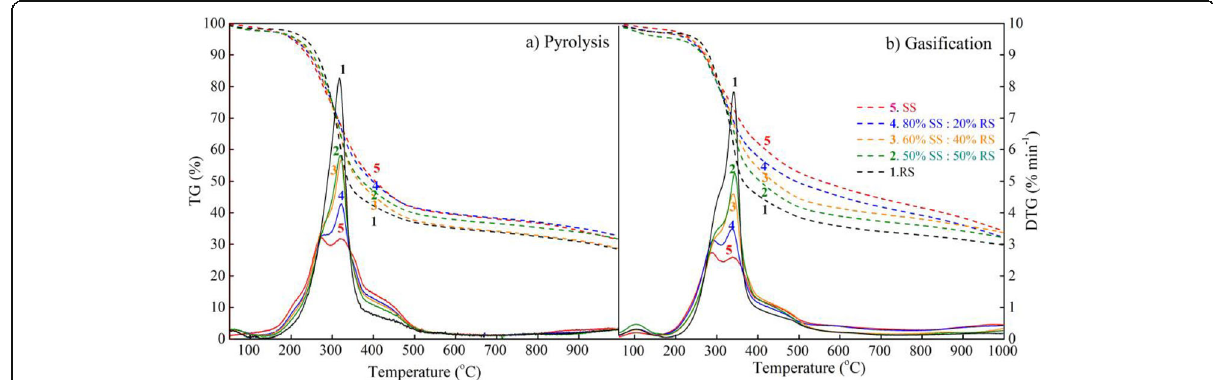
Fig. 2 A comparison between TG/DTG curves detected from rice straw, sewage sludge and their additives pyrolysis and air gasification at 10 °C min − 1 heating